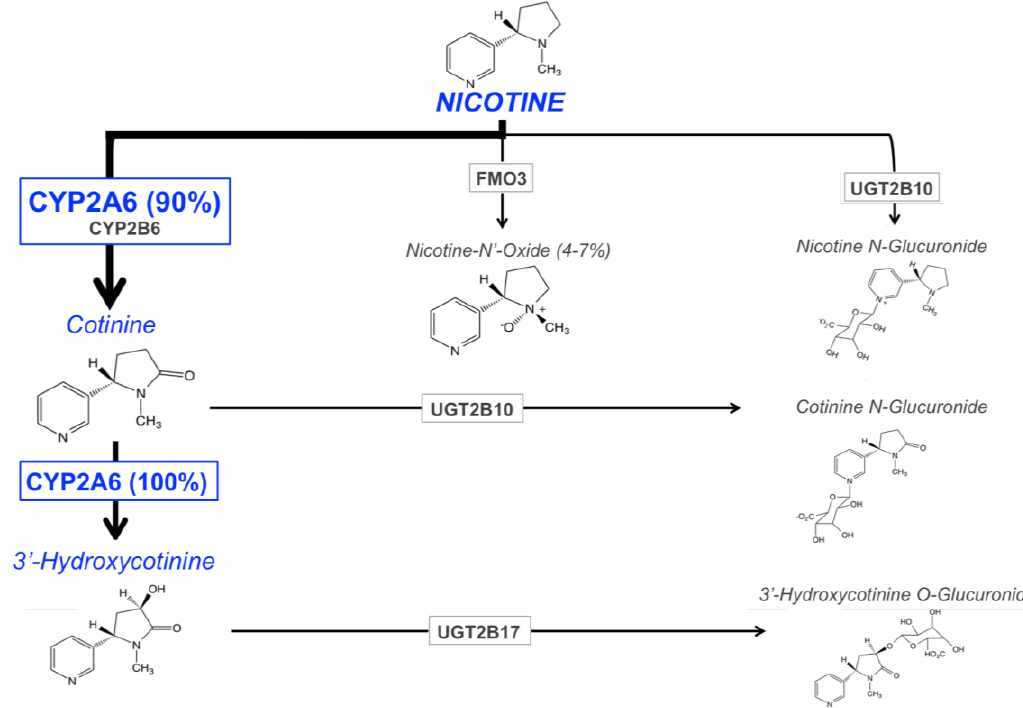
Figure 1. The major pathways of nicotine metabolism and clearance. The bolded arrow represents the predominant pathway of nicotine metabolism (CYP2A6 is responsible for 90% of nicotine’s metabolism to cotinine). Adapted from Hukkanen et al., 2005 [103] and Tanner et al., 2015 [41].